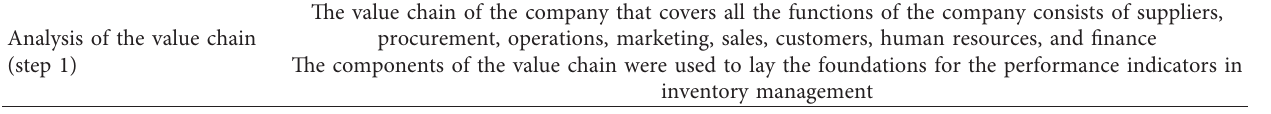
Table 5: Application of step 1 of the methodology (analysis of the value chain).